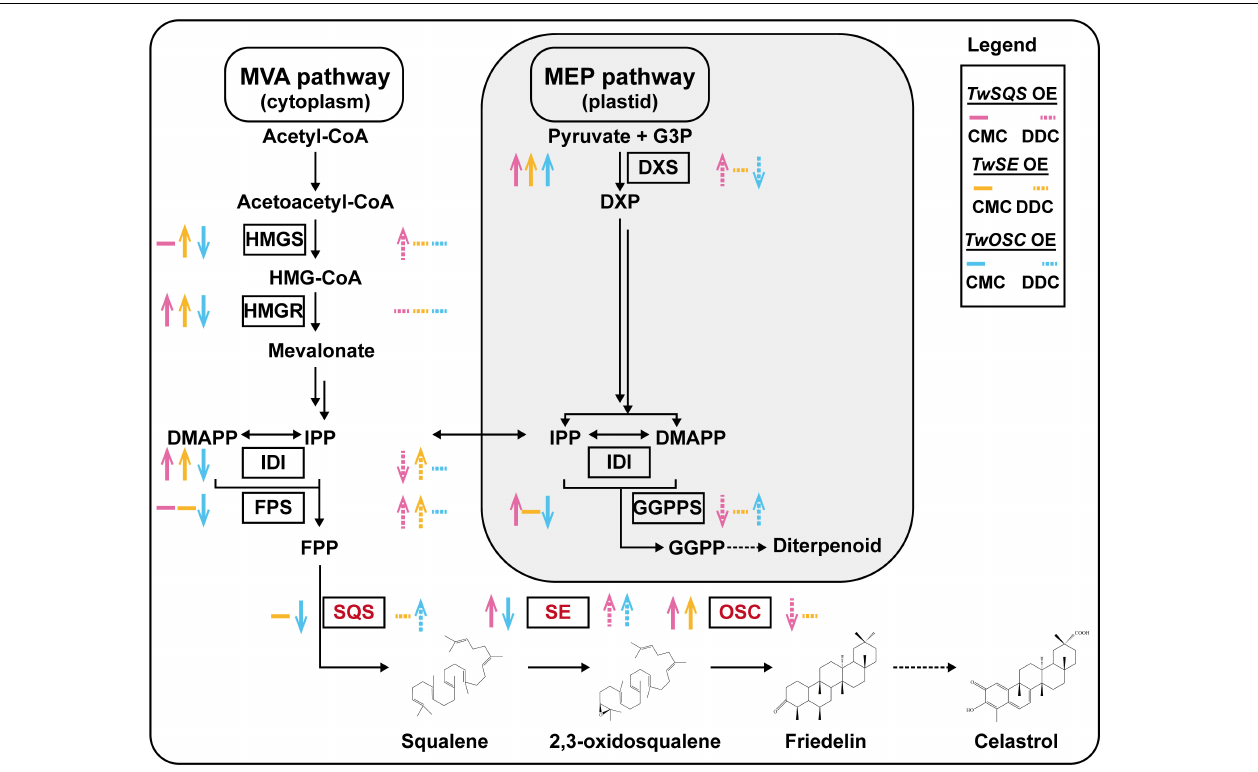
FIGURE 5 | The expression trends of genes involved in terpenoid biosynthetic pathway after overexpression of TwSQS , TwSE , and TwOSC based on Figure 4 . A black single arrow represents a one-step reaction, a black double arrow represents a multistep reaction, and a black dotted arrow represents unknown steps. The colored upward or downward arrows indicate corresponding increase and decrease in gene expression. Colored horizontal line represents no statistical significance between the overexpression group and the pH7WG2D control group. The SQS, SE, and OSC enzymes analyzed in this study are highlighted in red. OE,